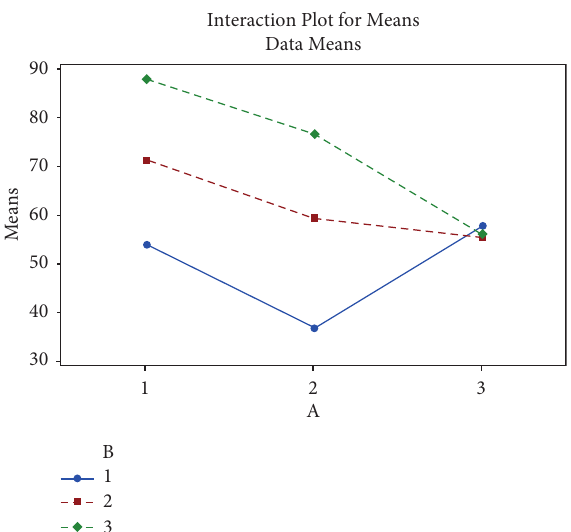
Figure 10: Effect of interaction between rotational speed and traverse speed ( A × B ) on average traverse force.